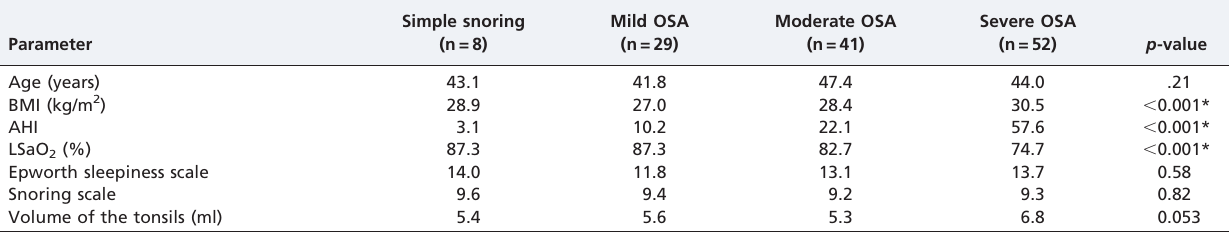
Table 1 - Clinical data of the studied groups (mean). Parameter